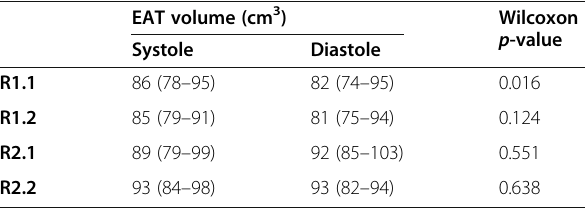
Table 2 Median epicardial adipose tissue volume at systole and diastole with different readers